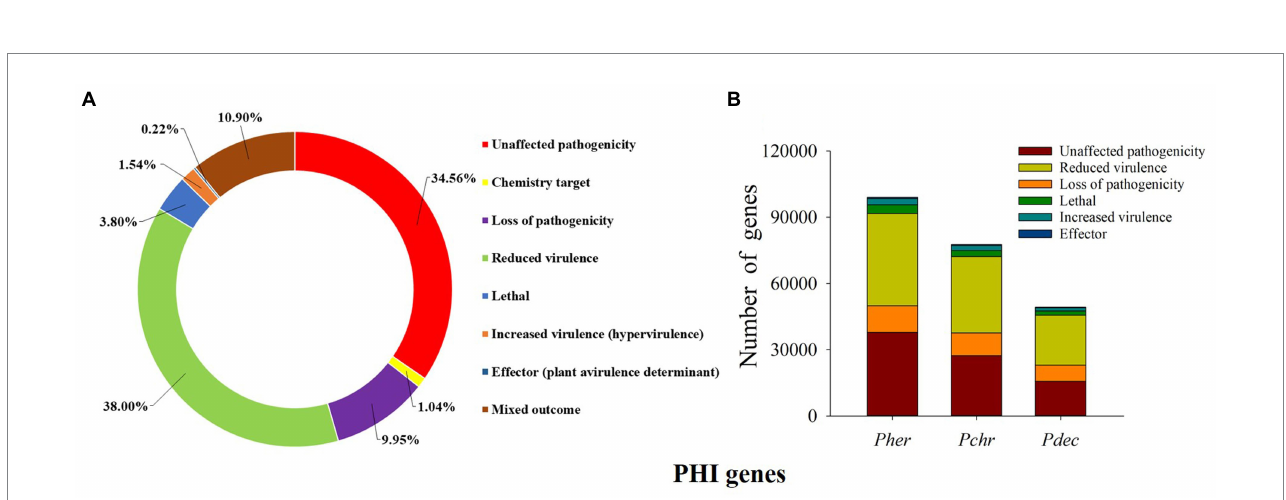
FIGURE 5 Putative pathogen-host interactions (PHI) genes. (A) The distribution of phenotypic categories of PHI gene orthologs in the Penicillium herquei genome. (B) Comparison of PHI genes in the three Penicillium species, P. herquei ( Pher ), P. chrysogenum ( Pchr ), and P. decumbens ( Pdec